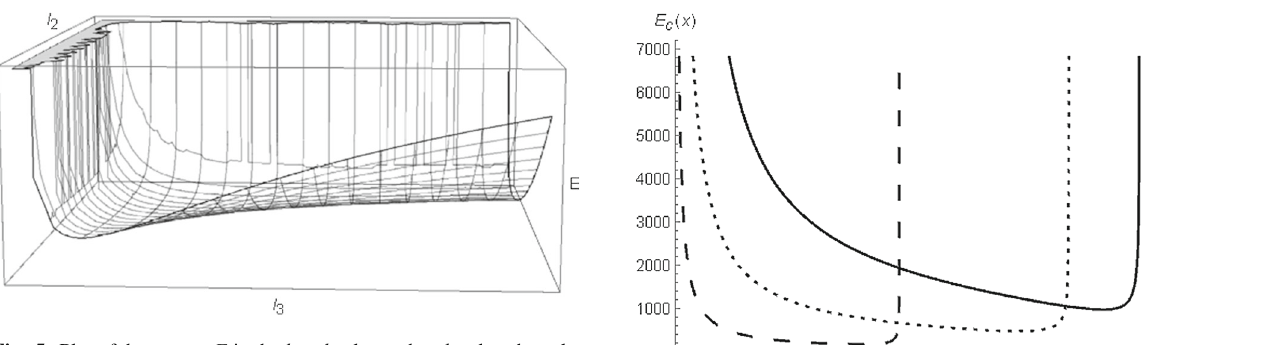
Fig. 5 Plot of the energy E in the l 2 − l 3 plane when l 1 takes the value that corresponds to the minimum of E